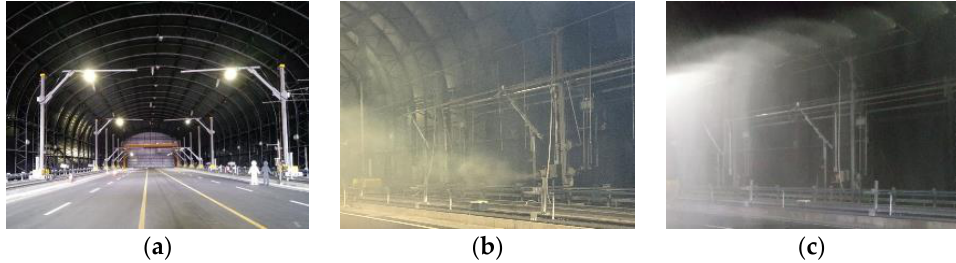
Figure 7. Implementation of fog and rain conditions in the test facility: ( a ) Inside view of the climatic tunnel; ( b ) fog generator operation inside the tunnel; ( c ) rainfall by rain nozzles inside the tunnel.